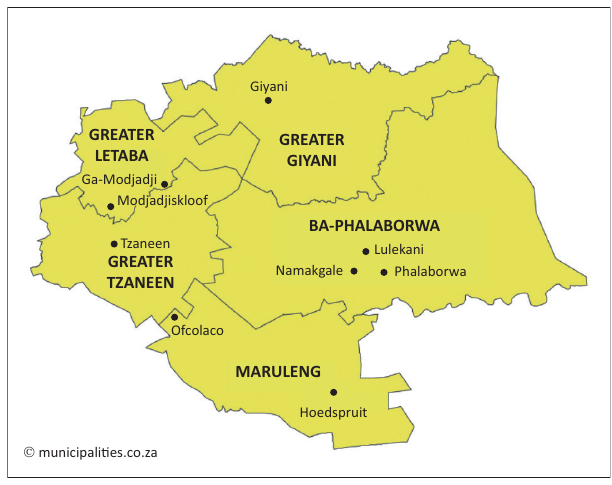
FIGURE 1: The map depicting Ba-Phalaborwa